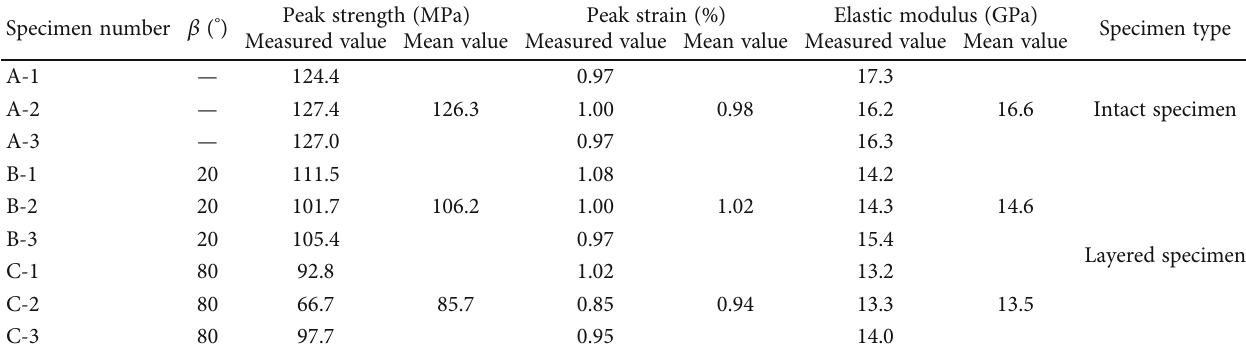
Table 1: Mechanical parameters of selected samples (units: ° , MPa, %, and GPa). Specimen number β ( °